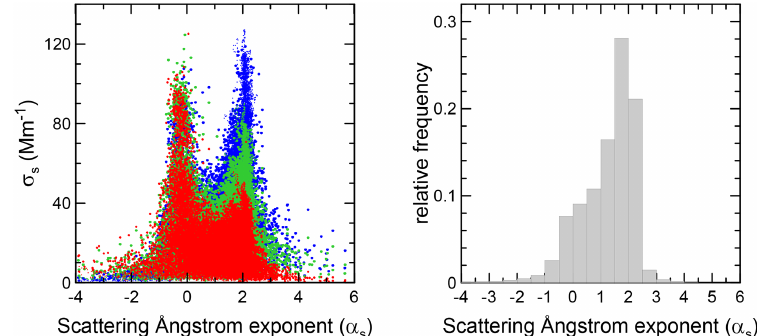
Figure 4. Left: scattering coefficient ( σ s ) at 450, 550, and 700nm versus the scattering Ångström exponent ( α s ). Cases with extremely negative ( < − 2) and positive ( > 4) values of α s are always related with very low scattering coefficients, and are likely due to instrumental noise under low scattering conditions. Right: frequency of occurrence of α s obtained considering vertical profiles data from all TRAQA and SAFMED flights.